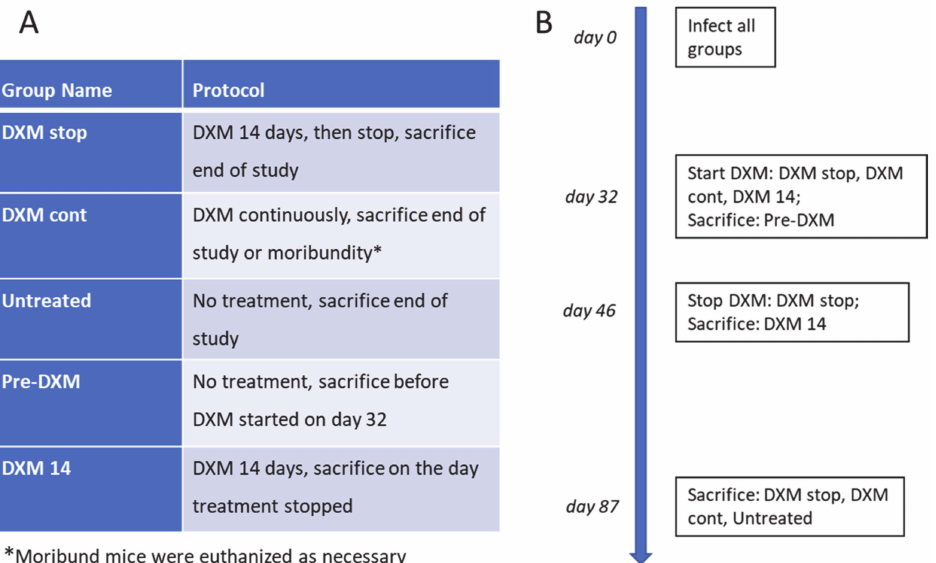
Figure 2. Treatment and sacrifice protocol for comparison of mice treated for two weeks or continu- ously with DXM, 6 mg/L, in drinking water. Groups and treatment conditions ( A ) and timeline of study ( B ) for 2-week and continuous administration of DXM with right lung fungal burden and left lung